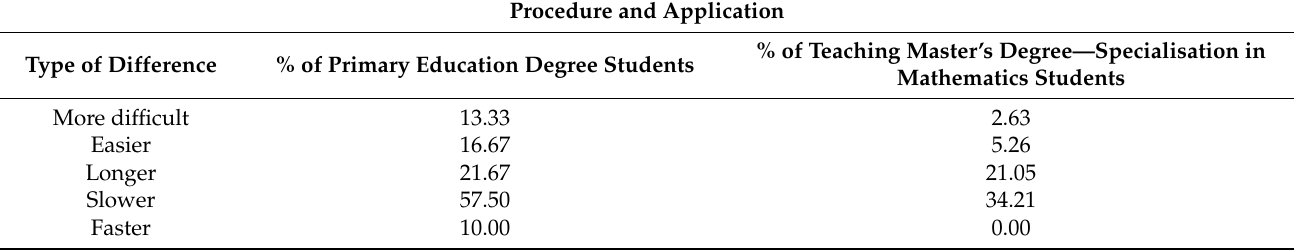
Table 2. Differences found between the degree and master’s degree students, regarding procedure and application of the multiplication